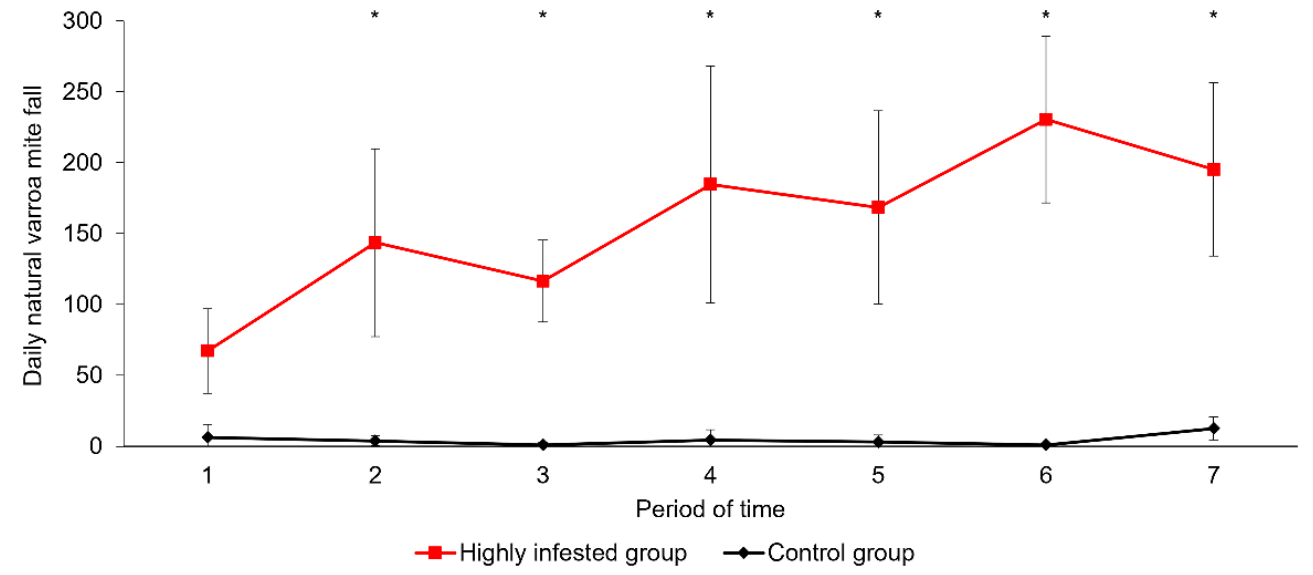
Figure 1. Daily varroa mite fall in highly infested and control hives over time. Average data (+/−SD) over determined periods for each group are shown in the figure. Daily varroa mite fall was signifi- cantly higher in infested hives compared to control hives for most periods (*, p < 0.0001, post hoc Tukey test in LMM) except for the first period ( p = 1.00, post hoc Tukey test in LMM).